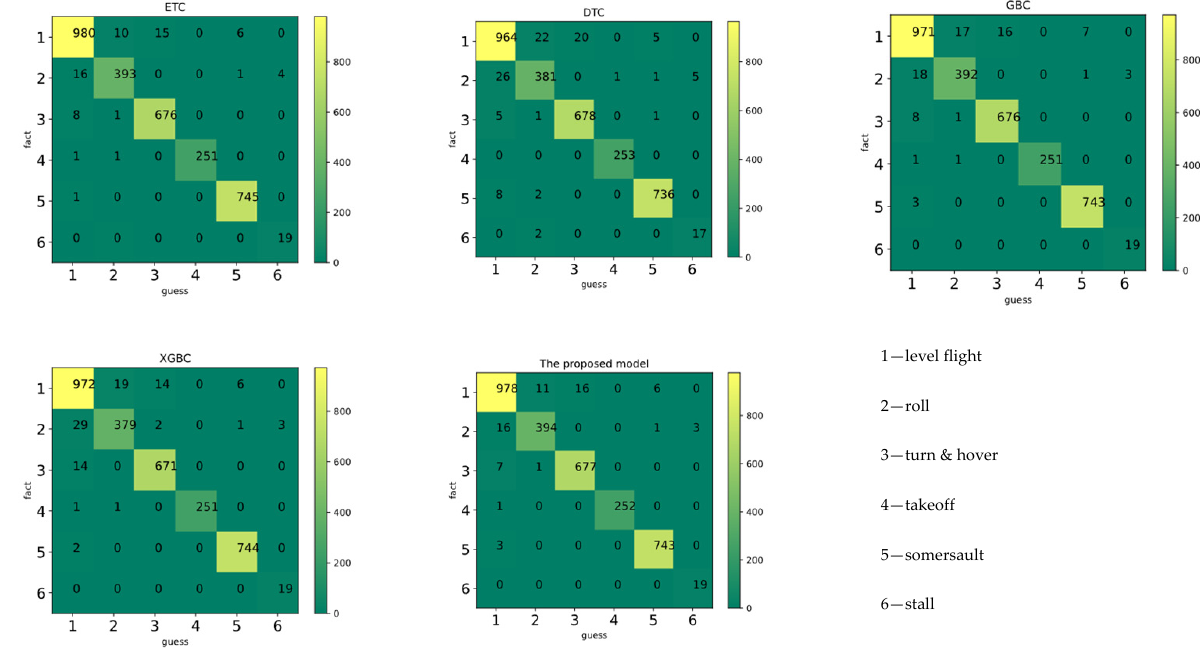
Figure 9. The confusion matrix of classifiers after improvement. Table 9. The classification report of classifiers after improvement.